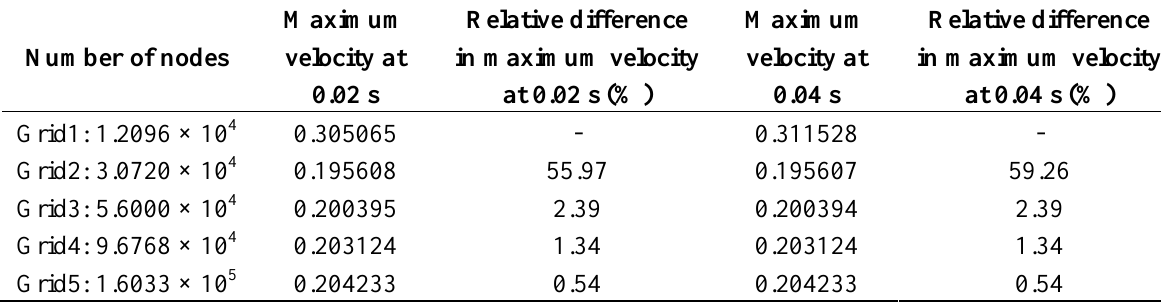
Table 1. The analysis of the grid size